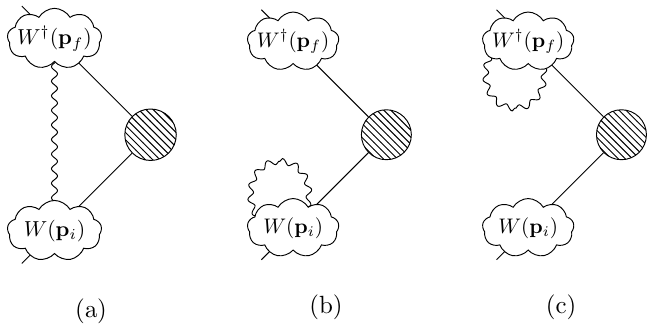
Figure 2. We consider the simple case of 1 ! 1 gravitational potential scattering, where the incoming and outgoing momenta are p i and p f , respectively. The (cid:12)gures illustrate di(cid:11)erent contri- butions to the FK amplitude of this process. Blob represents the internal diagram, including the gravitational